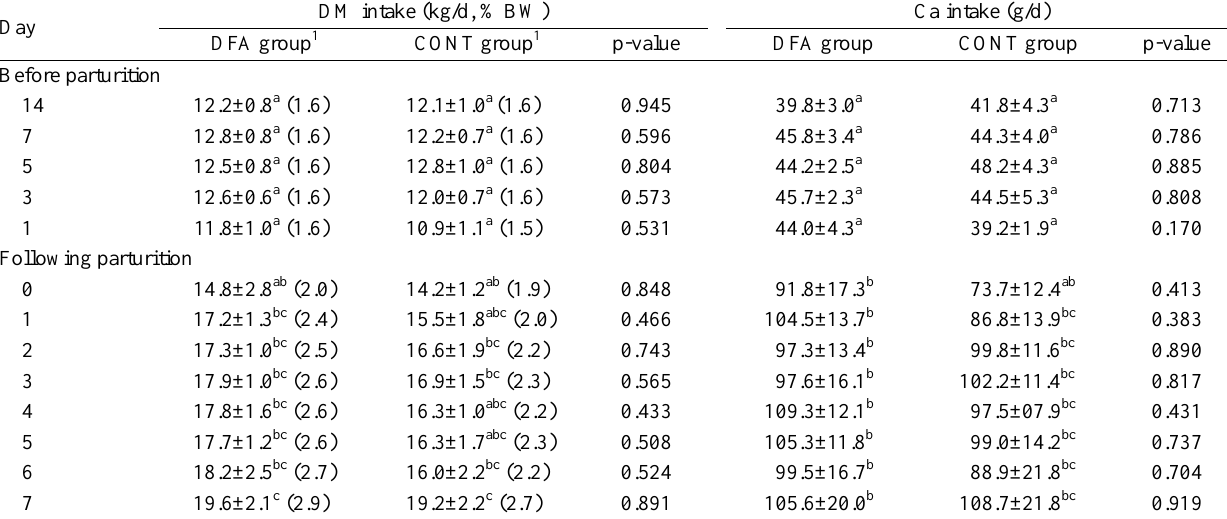
Table 3. Changes in dry matter and calcium intakes before and following parturition periods relative to cows in DFA and CONT groups 1